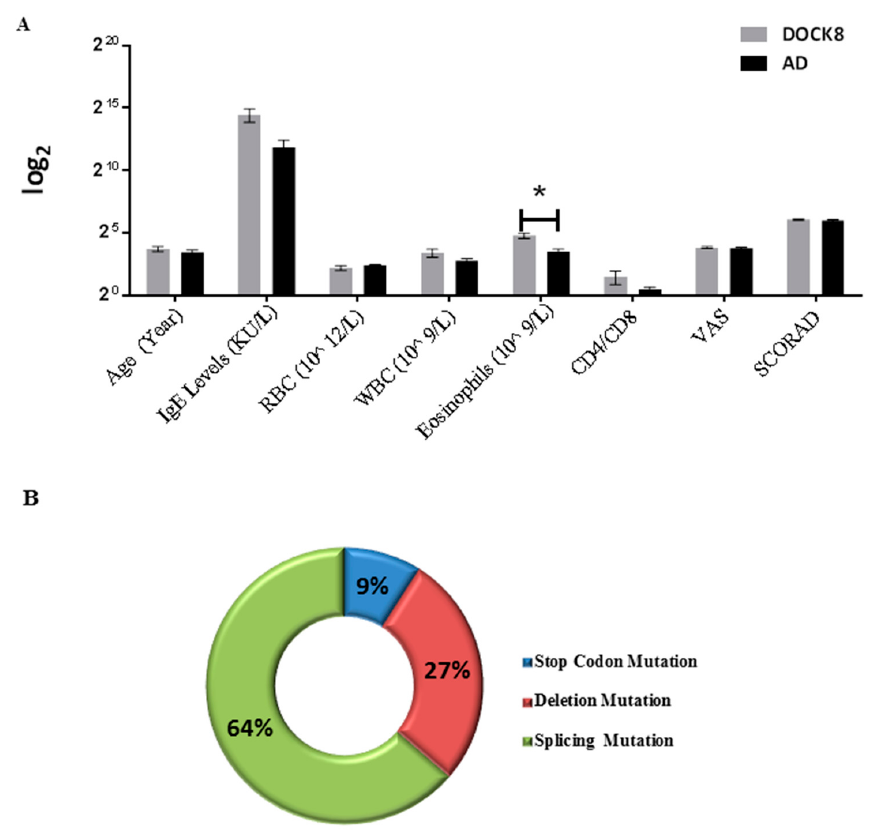
Figure 1. Demographic profiles in dedicator of cytokinesis 8 (DOCK8)-deficient and atopic dermatitis (AD) patients: ( A ) Only blood eosinophil counts were statistically di ff erent between DOCK8-deficient and AD patients. ( B ) Distribution of mutations in DOCK8-deficient patients. (one-way analysis of variance (ANOVA), post hoc Tukey’s method, ** p -value < 0.05, * p -value < 0.001). SCORAD, Severity Scoring of Atopic Dermatitis; VAS, Visual Analogue Scale. (measuring itch